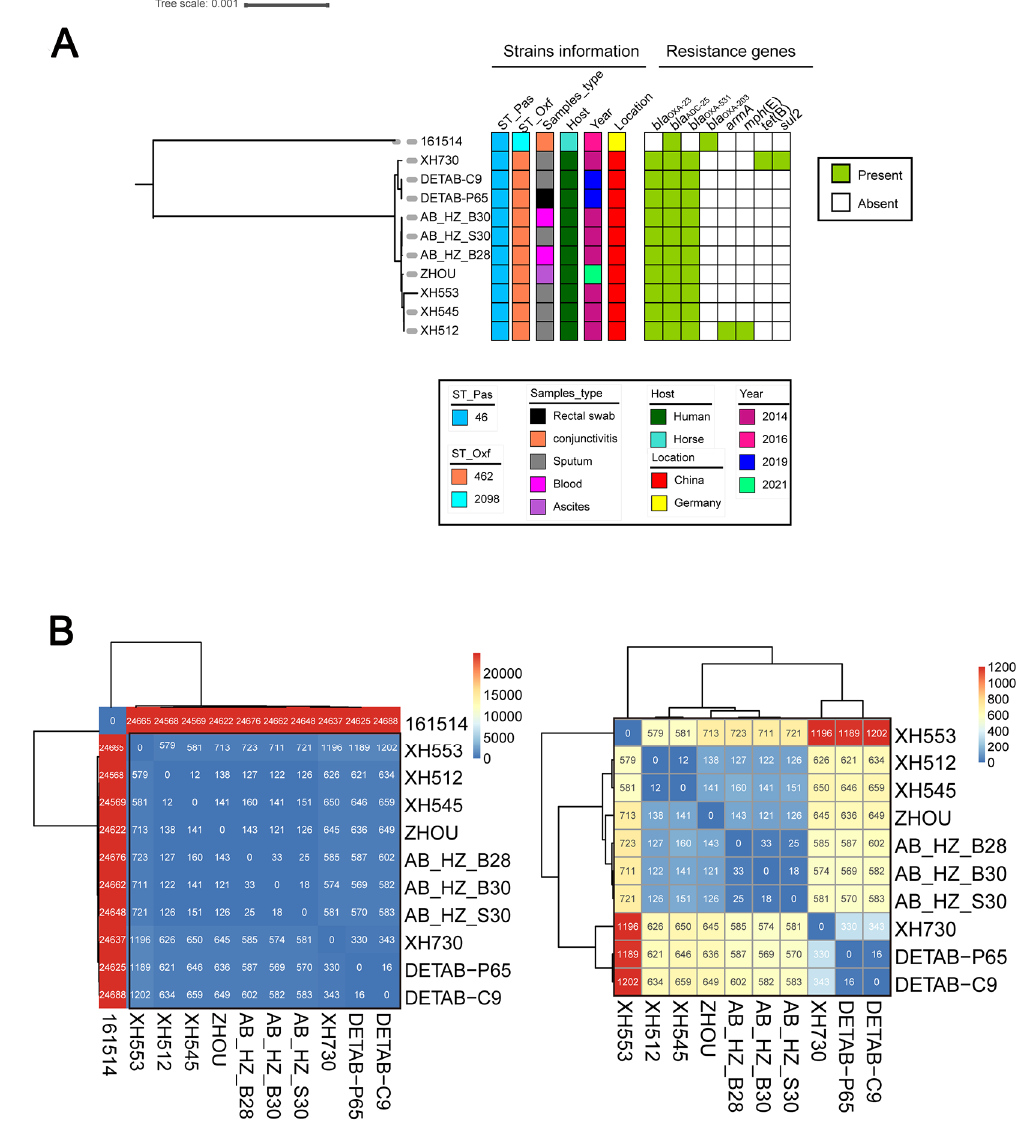
Figure 3. Phylogenetic analysis of 11 ST46 Pas A. baumannii strains and SNPs matrix values among ST46 Pas strains. ( A ) The tree was built with Snippy v4.4.5 and FastTree using RAxML under the GTRGAMMA model with DETAB-C9 as the reference strain and visualized with iTOL v5. Isolate name, Pasteur and Oxford MLST schemes, sample type, host, collection locations, isolation date and the heatmap of resistance genes are shown for each strain. The GenBank accession numbers of other ST46 Pas A. baumannii strains from the NCBI GenBank public database are as follows: 161514